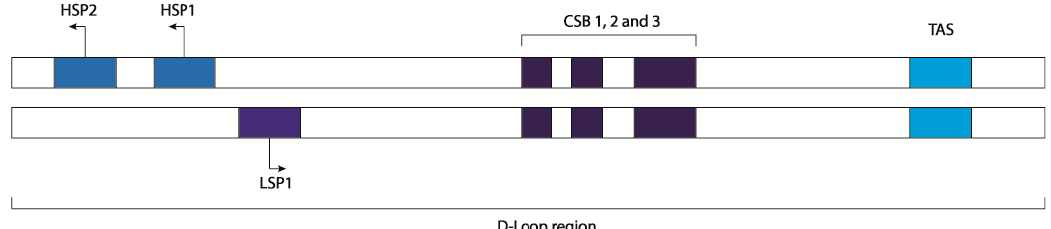
Figure 1. Schematic representation of mitochondrial D-loop region. Heavy strand promoters 1 and 2 (HSP1 and HSP1), light strand promoter 1 (LSP1), conserved sequence blocks 1, 2, and 3 (CSB I, II, and III), and termination-associated sequences (TAS).